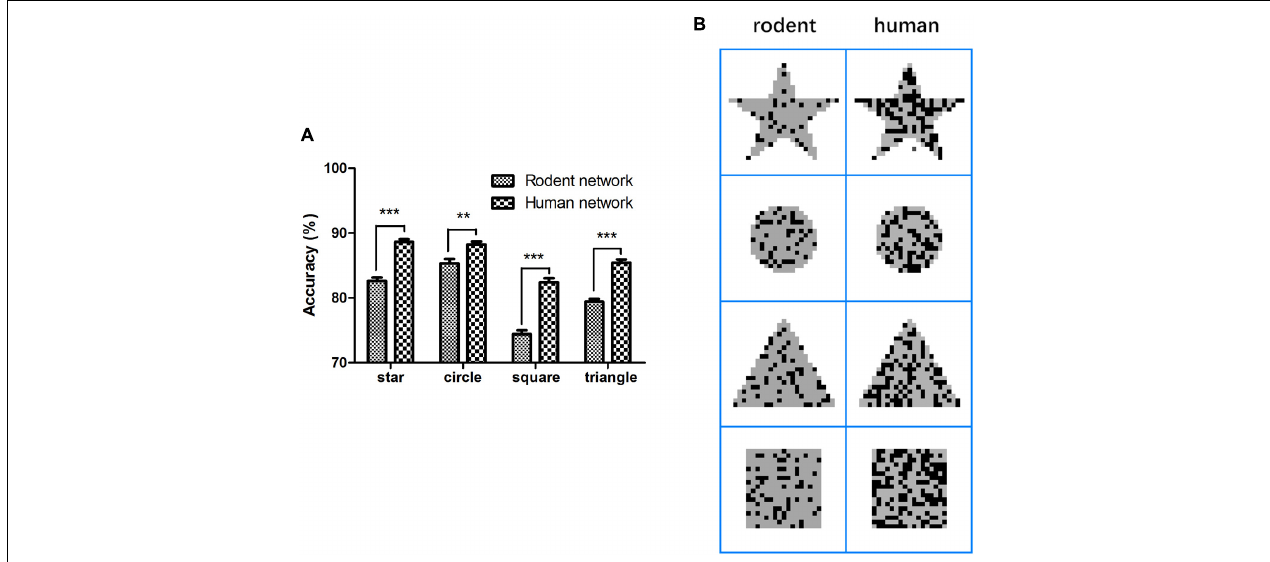
FIGURE 3 | Comparison of accuracy and completeness in rodent and human neural network. (A) Network persistent activity performance, (B) rodent and human network input (gray) and output (dark) comparison. The error bars represent the standard error of the mean of nine independent experiments, ** P < 0.01, *** P <